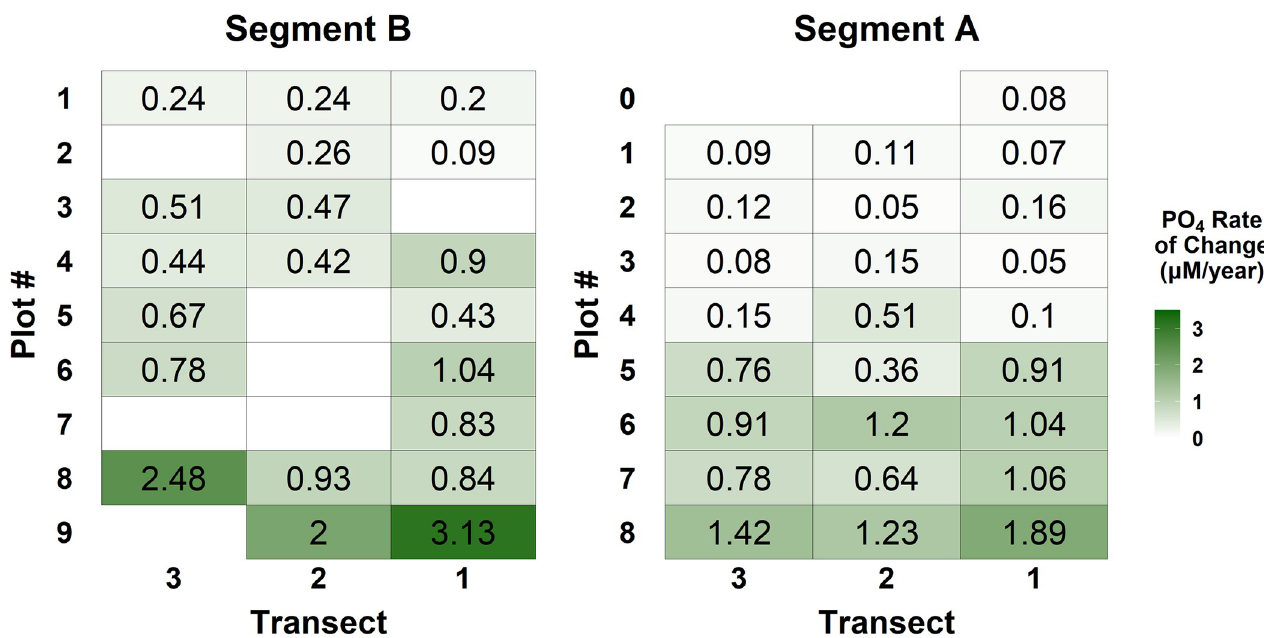
Fig 5. PO 4 rates of change. Rates of change in PO 4 ( μ mol L -1 ) corresponding to each permanent vegetation monitoring plot across Segments A and B. The numbers in each plot represent the slope of the linear fit between average monthly porewater PO 4 concentration (from May-August) and years from 2009–2019 where p < 0.05. Plot shading visualizes the spatial variability in rates of change, and plots with no number/shading had non-significant temporal trends. Segment B is upstream and west of Segment A, so they are plotted here as they are oriented in the field.